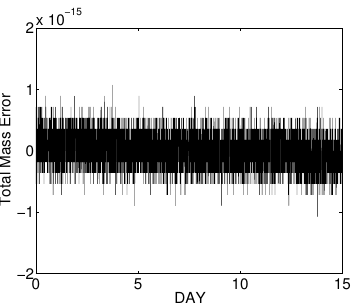
Figure 10. Normalized conservation error of total mass on grid G 12 for case 5.